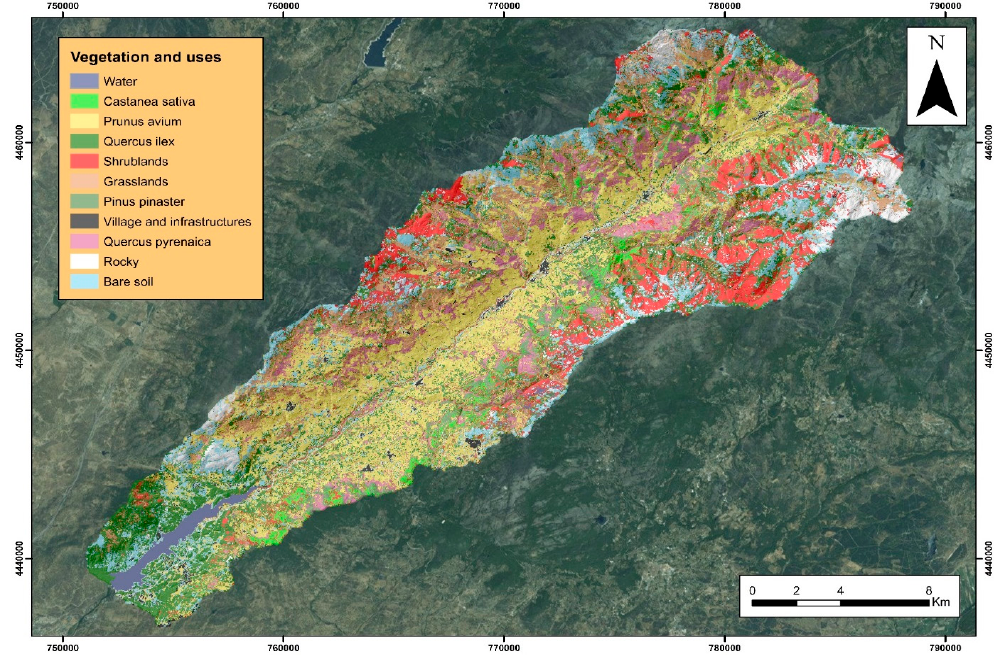
Figure 10. Land-use and vegetation mapping.